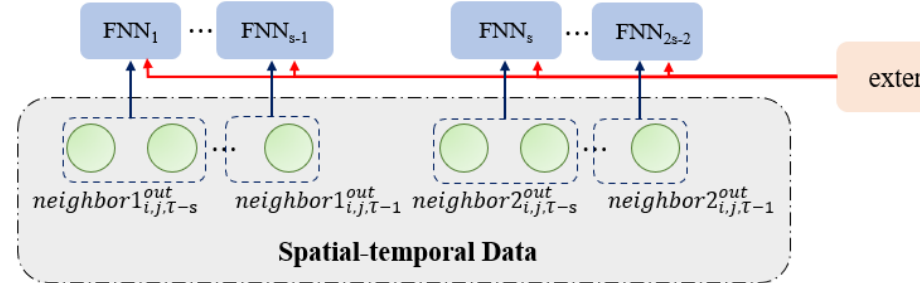
Figure 9. Structure of the spatial-temporal module.